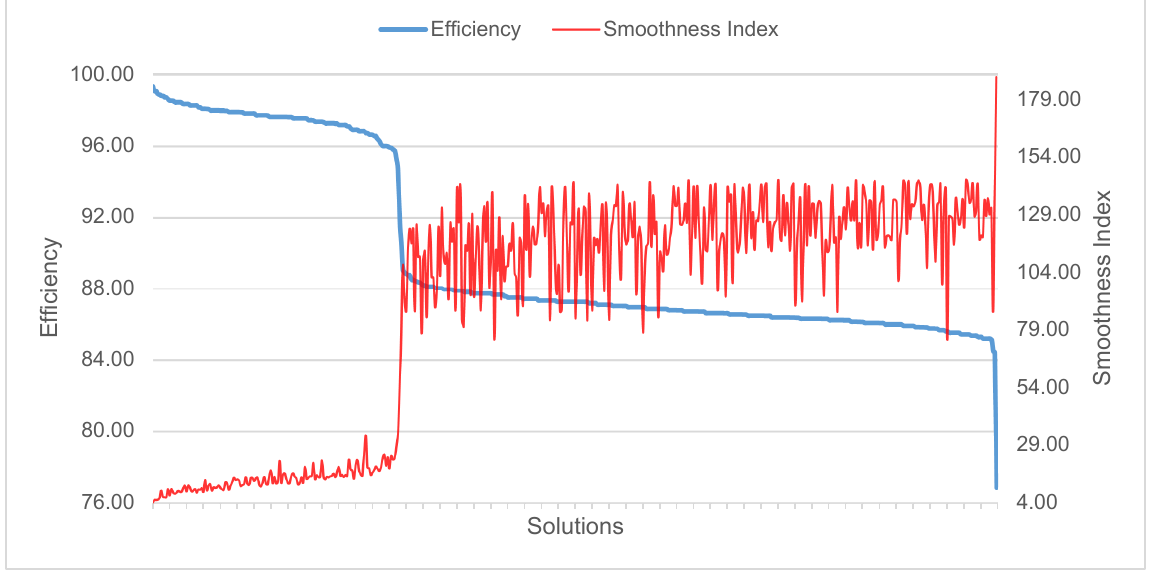
Fig. 3. Line efficiency & line smoothness index values of the feasible solutions